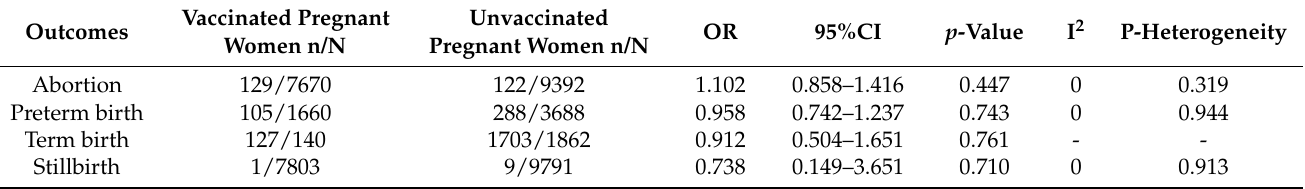
Table 8. Adverse fetal outcomes among pregnant women with and without COVID-19